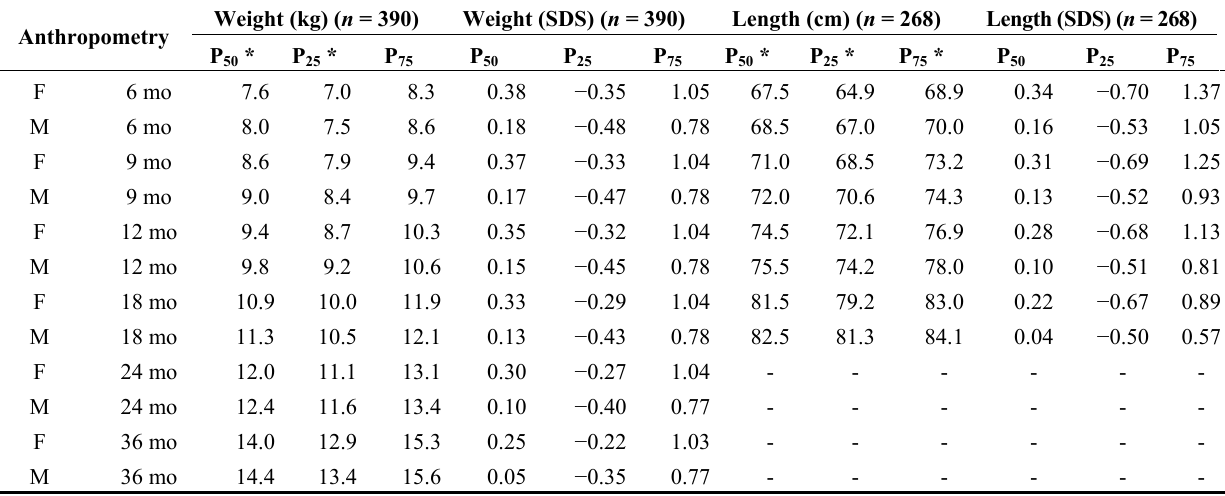
Table 3. Percentiles of weight and length in the pooled sample of NI636 children. Anthropometry